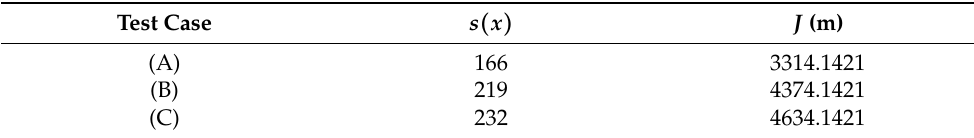
Table 3. A* results for test cases (A), (B) and